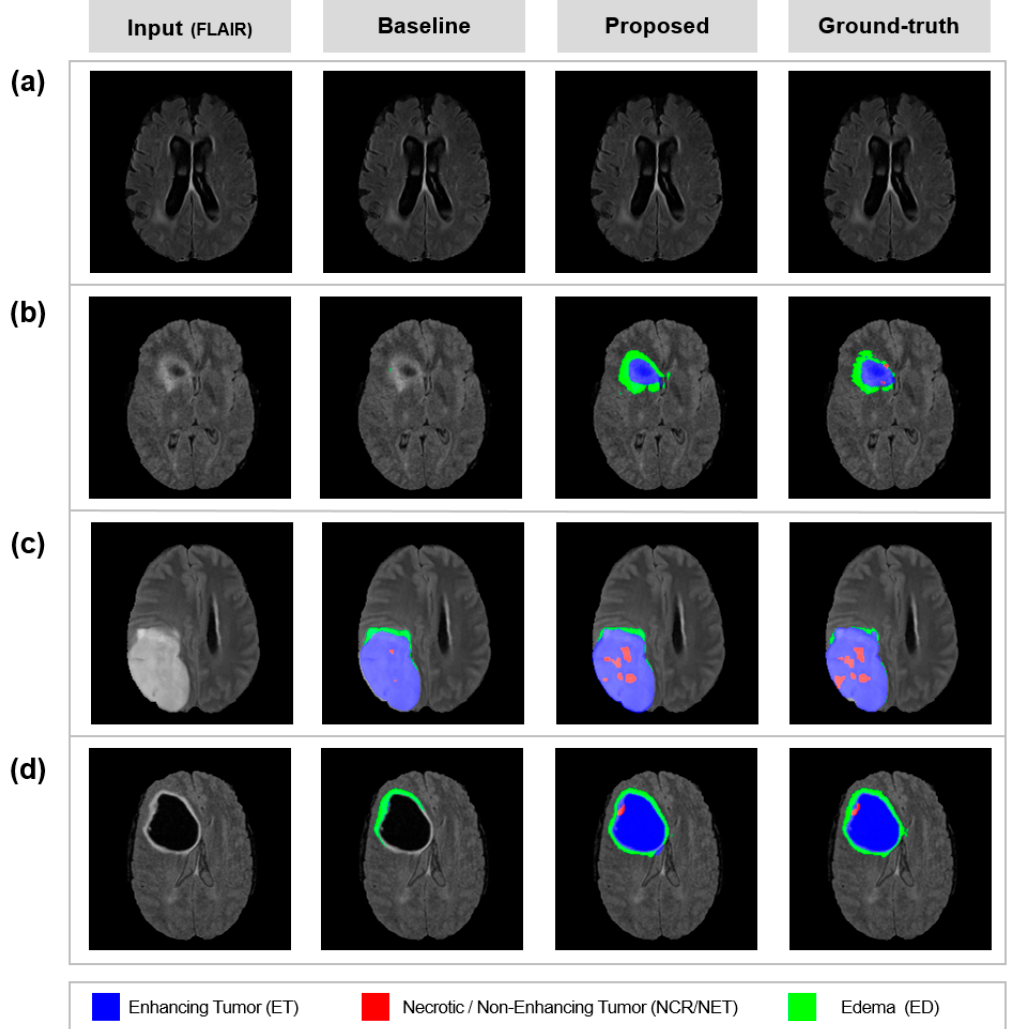
Figure 5. Uncertainty exploitation results: Automatic segmentation results by baseline/proposed method and manual segmentation by experienced neurologists (ground-truth). The images are subsequent results of Figure 4. The proposed method can exploit uncertainty maps to perform brain tumor segmentation. ( a ) scans with no tumor. ( b ) scans with ET and ED. ( c ) scans with all lesions. ( d ) scans with all lesions.